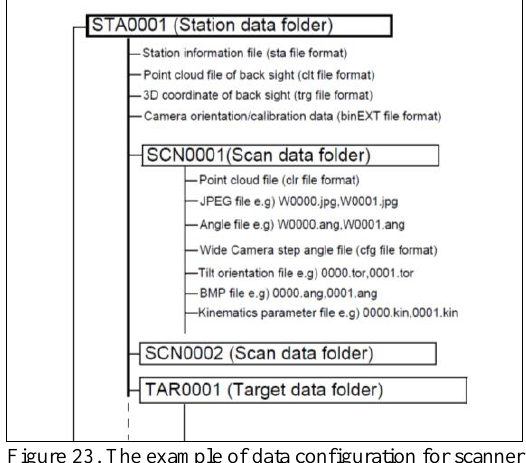
Figure 20. Scanner view of the slope taken from different scanner location which comprises of station 1 and 2